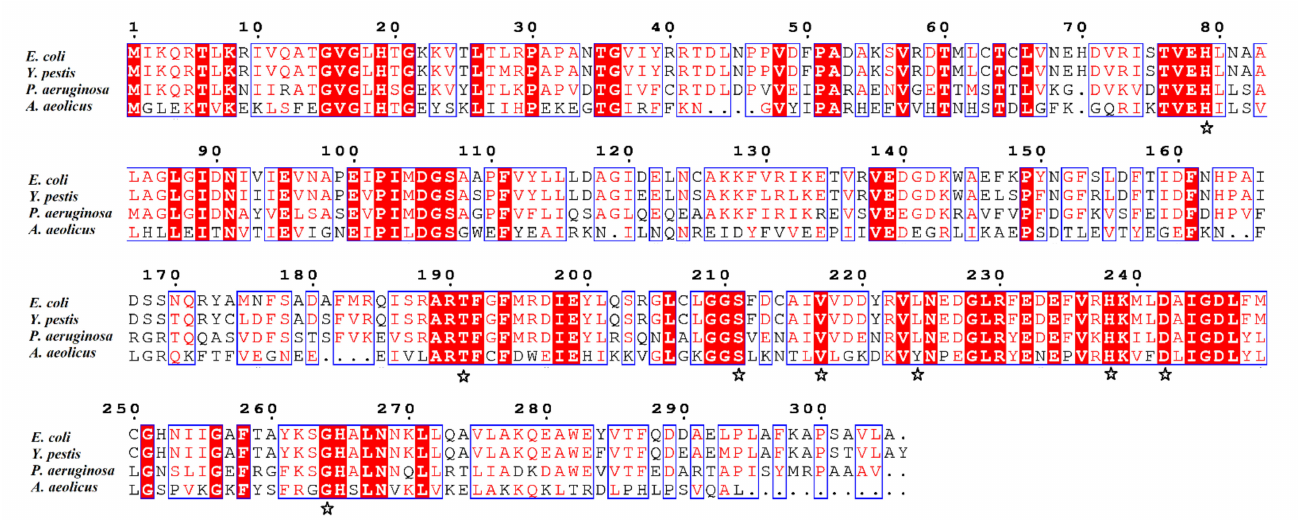
Figure 4. Sequence alignment of diverse LpxC orthologs. The sequences are from Escherichia coli (UniProtKB ID: P0A727.1), Yersinia pestis (NCBI ID: Q8ZIE3.2), Pseudomonas aeruginosa (UniProtKB ID: P47205.2), and Aquifex aeolicus (NCBI ID: O67648.1). Residues indicated in red are similar or identical. The key ligand-binding residues are marked with